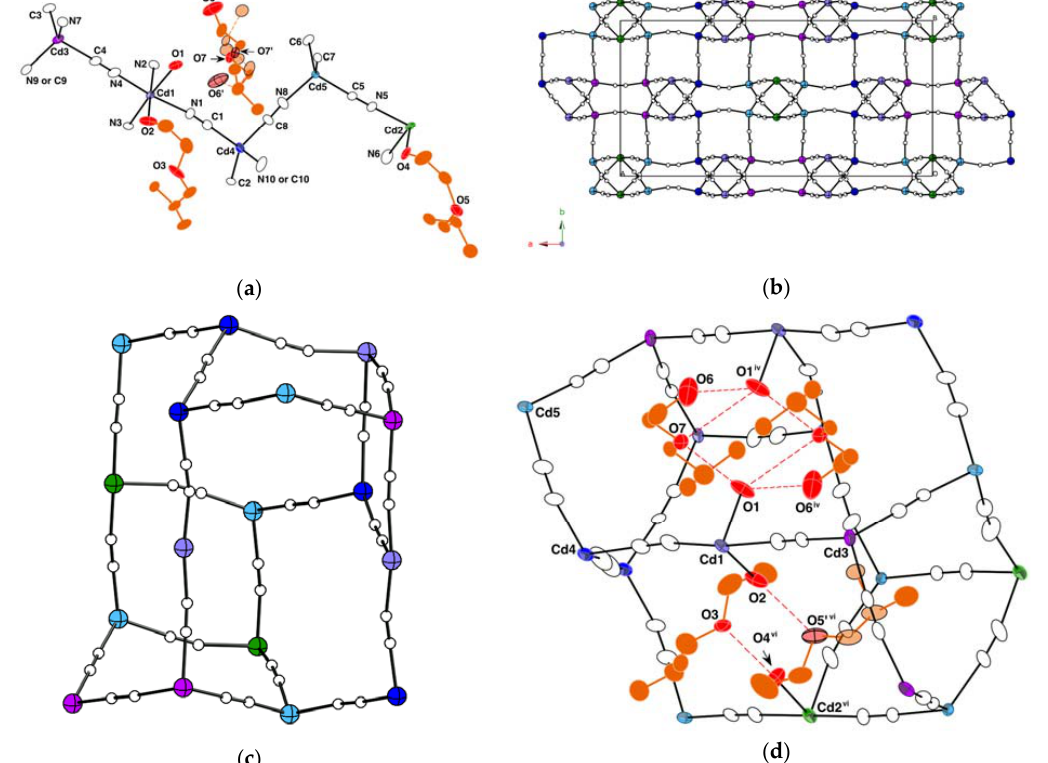
Figure 1. The crystal structure of I . H atoms and disordered parts are omitted for clarity: ( a ) Asymmetric unit of I . Displacement ellipsoids are drawn at the 50% probability level. Because the arrangements of cyanides (Cd ‐ NC ‐ Cd or Cd ‐ CN ‐ Cd) are disordered, the cyanide atoms are labeled arbitrarily; ( b ) The Cd(CN) 2 network structure of I along the c axis; ( c ) [4 2 .5 2 .6 2 .8 2 ] tile; ( d ) Hydrogen bonds between iBucel and water molecules in [4 2 .5 2 .6 2 .8 2 ] cavities of cadmium cyanide network. Displacement ellipsoids are drawn at the 50% probability level. (Symmetry codes: iv = − x + 1/2, − y + 1/2, − z + 2; vi = − x + 1/2, − y + 1/2, − z + 1).